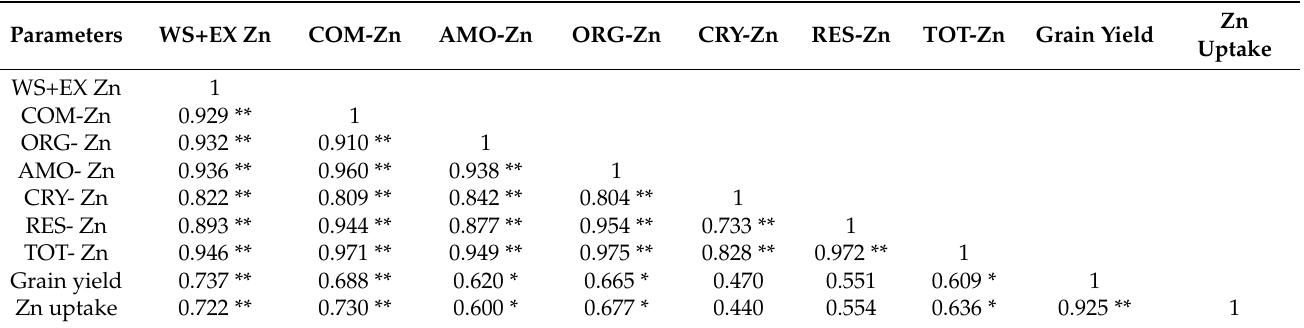
Table 7. Correlation among different forms of zinc in soil with wheat grain yield and zinc uptake.